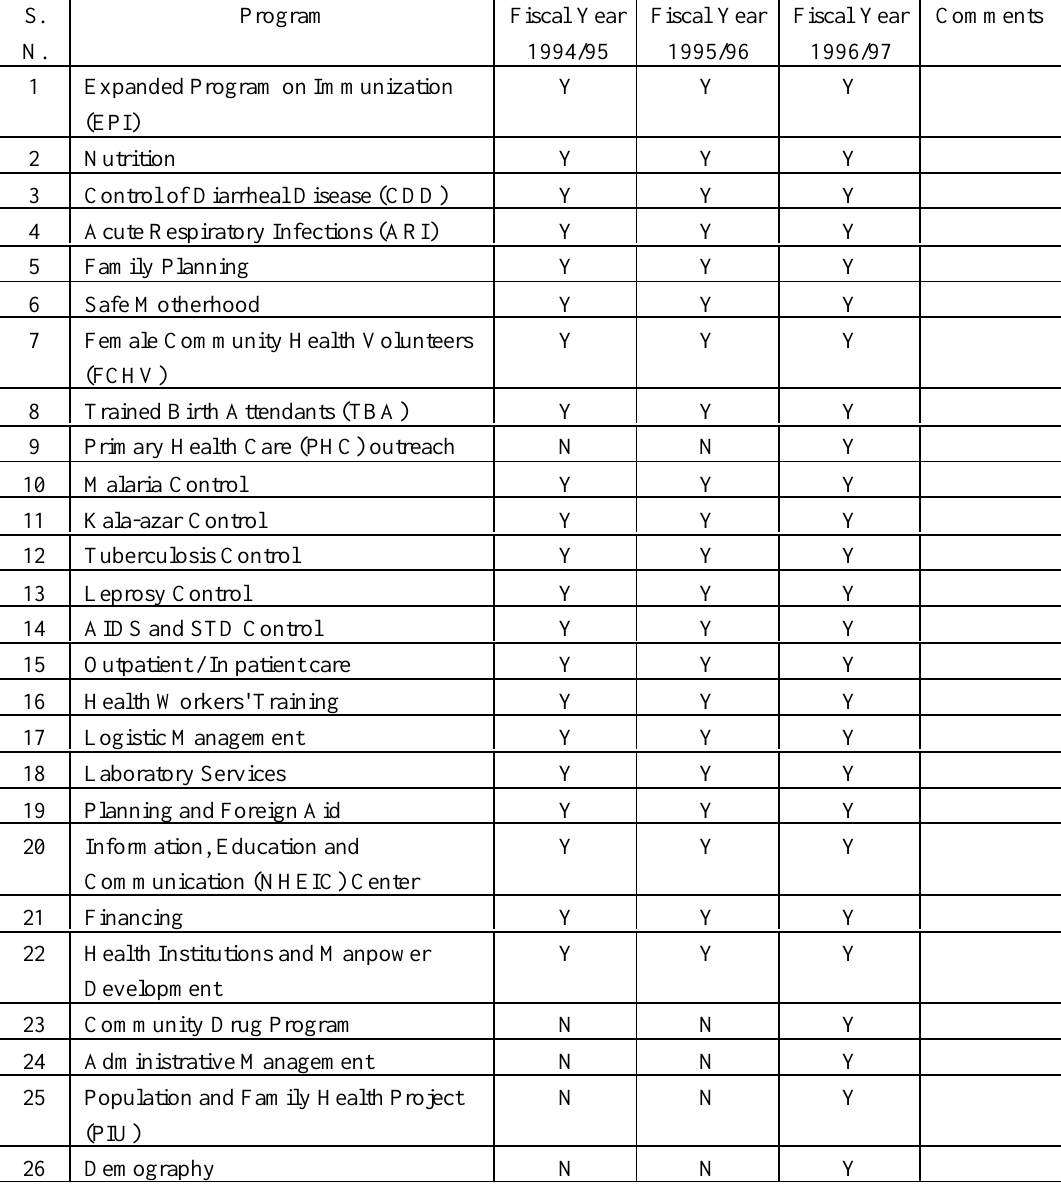
Table 1: Inclusion of Various programs in the annual report.